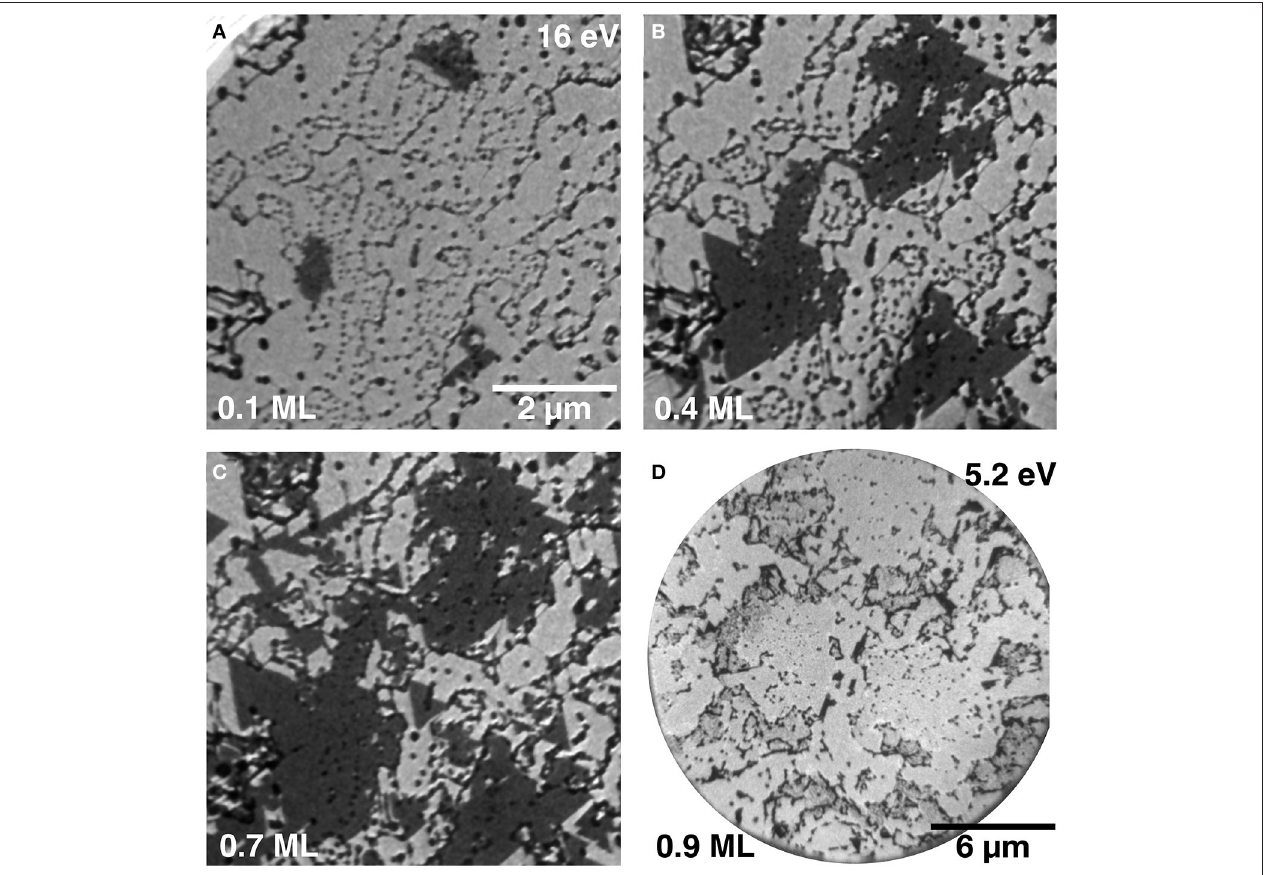
FIGURE 1 | Low-energy electron microscopy (LEEM) time-lapse sequence of the MoS 2 growth process recorded at 16eV kinetic energy with the Au surface appearing bright and the MoS 2 islands appearing dark for coverages of (A) 0.1ML, (B) 0.4ML, and (C) 0.7 ML. An overview LEEM image of the final coverage of 0.9ML taken at 5.2eV is shown in (D) , where the MoS 2 appears bright and the Au substrate appears